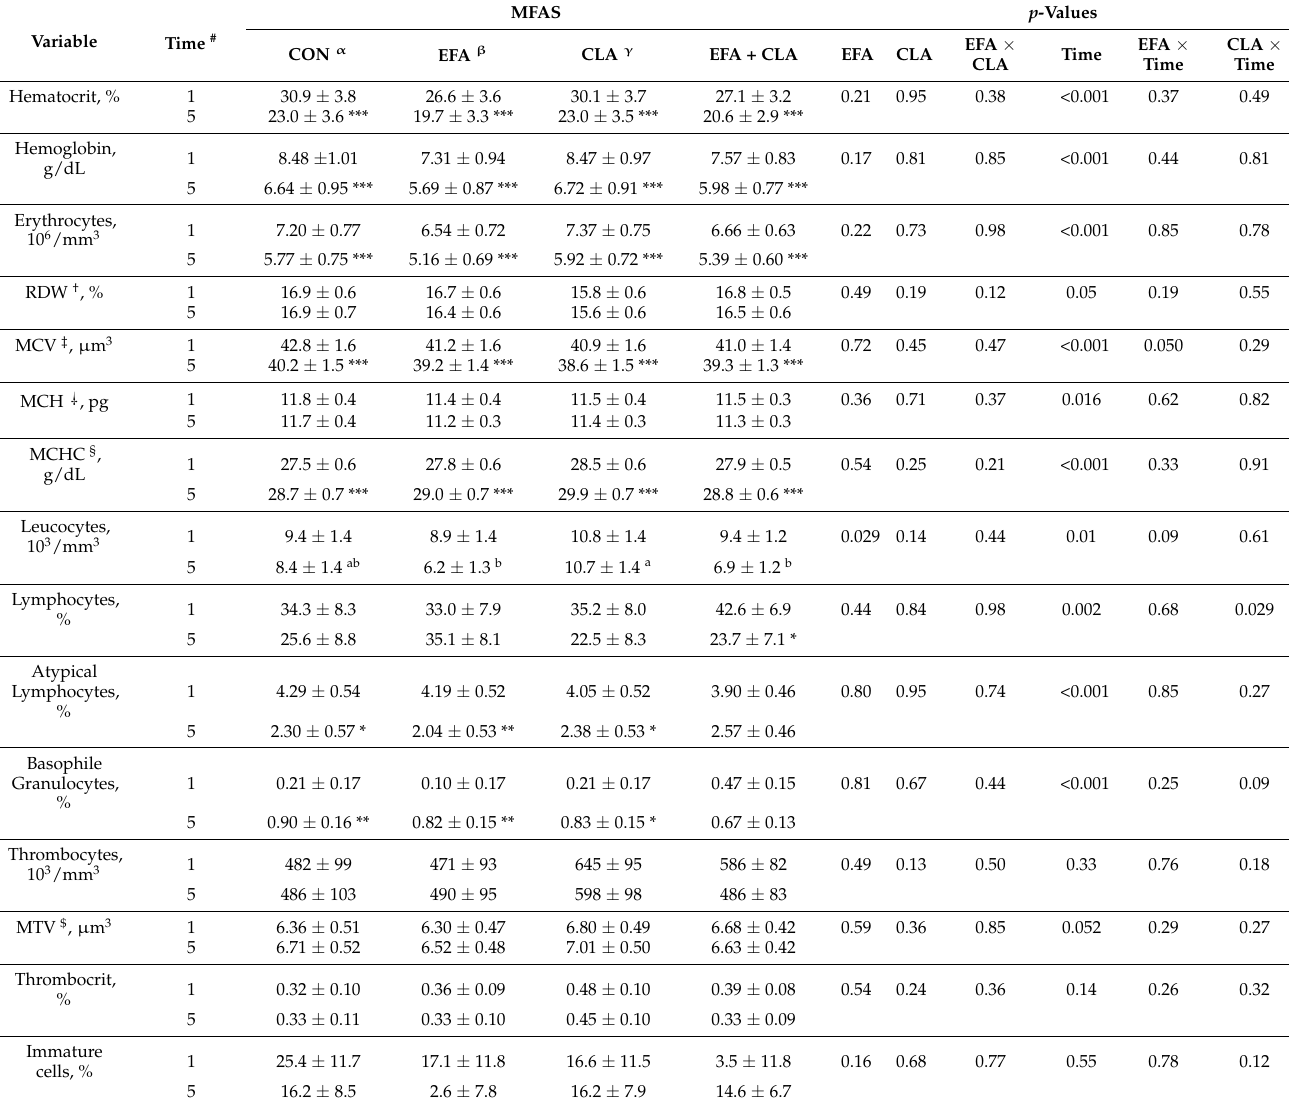
Table 2. Hematology of calves depending on maternal fatty acid supplementation (MFAS) and time after birth.